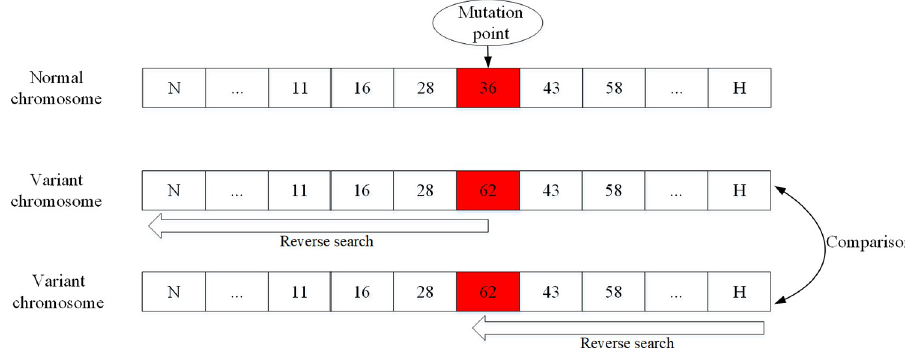
Fig 10. Mutation operation based on two-way